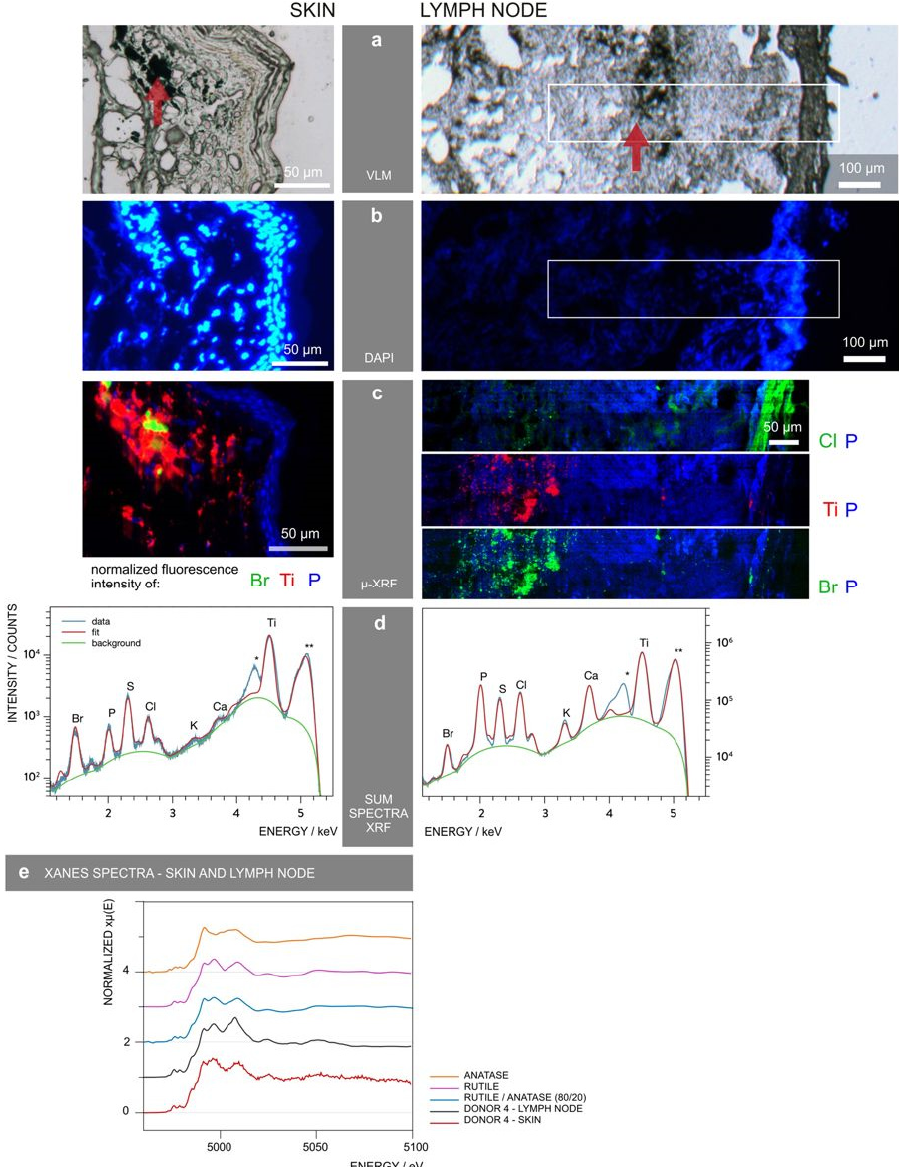
Figure 6. Synchrotron X-ray fluorescence was used to identify and locate tattoo particle elements in skin and lymph nodes of a donor. ( a ) Visible light microscopy (VLM) images of the area were mapped by μ -XRF and tattoo pigments were indicated by a red arrow. ( b ) 4 ′ ,6-diamidino-2-phenylindole (DAPI) staining of the tissues showing the cell nuclei. ( c ) μ -XRF maps of P, Ti, Cl, and/or Br. For the lymph node, these areas are marked in (a,b). ( d ) Average μ -XRF spectra over the full area displayed in (c) * diffraction peak from sample support; ** scatter peak of the incoming beam. ( e ) Ti K-edge micro-X-ray absorption near edge structure ( μ -XANES) spectra of skin and lymph node compared to the spectra of rutile, anatase, and an 80 / 20 rutile / anatase mixture calculation. This figure was obtained from Scientific Reports , 11395, Copyright 2017, Springer Nature. This work was published under a CC BY 4.0 license (http: // creativecommons.org / licenses / by / 4.0 / )